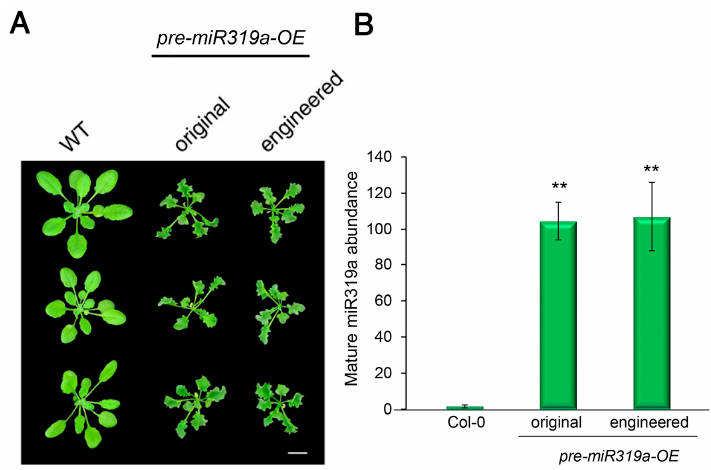
Figure 2. Engineered pre-miR319a retains its function in transgenic plants. (A) Phenotypic comparison of transgenic Arabidopsis plants expressing the original or engineered miR319a precursor. Four-week-old plants are shown. Scale bar, 0.5 cm. (B) Stem-loop RT-qPCR validates comparable production of mature miR319a from the original or engineered pre-miR319a in transgenic plants. The quantitative PCR data are presented as means ± SD of at least three independent repeats with endogenous snoR101 expression level set as 1. ** p < 0.01 (student’s t test). 2.3. amiRNAs Produced from Engineered Pre-miR319a Have Comparable Efficiencies in Gene Silencing